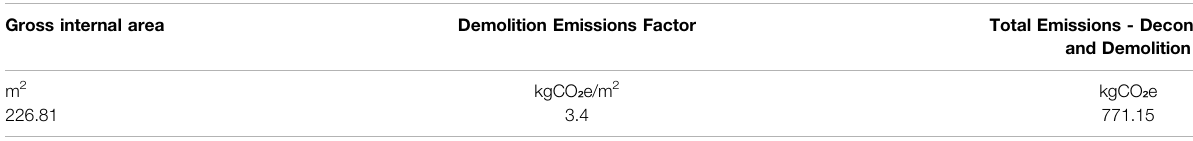
TABLE 8 | Deconstruction and demolition emissions — demolition of the building.